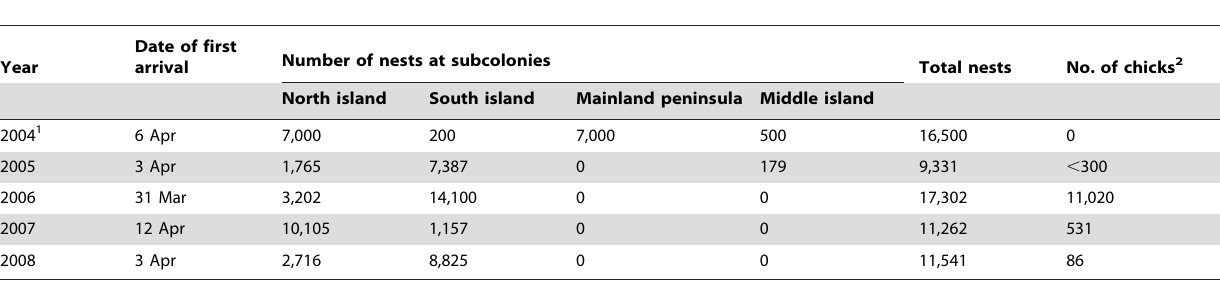
Table 1. American white pelican first arrival dates, nest initiation dates, and the numbers of nests and chicks for individual subcolonies at Chase Lake, North Dakota,